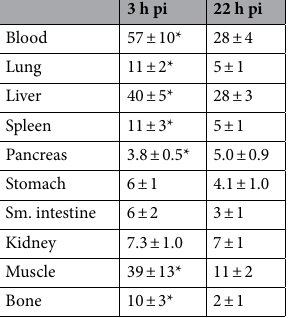
Table 1. Tumor-to-organ ratios. Female balb/c nu/nu mice with PC-3 xenografts were injected with 40 pmol (40 kBq) 66 Ga-NOTA-PEG 2 -RM26. *Indicates statistically significant (p < 0.03) differences between groups.